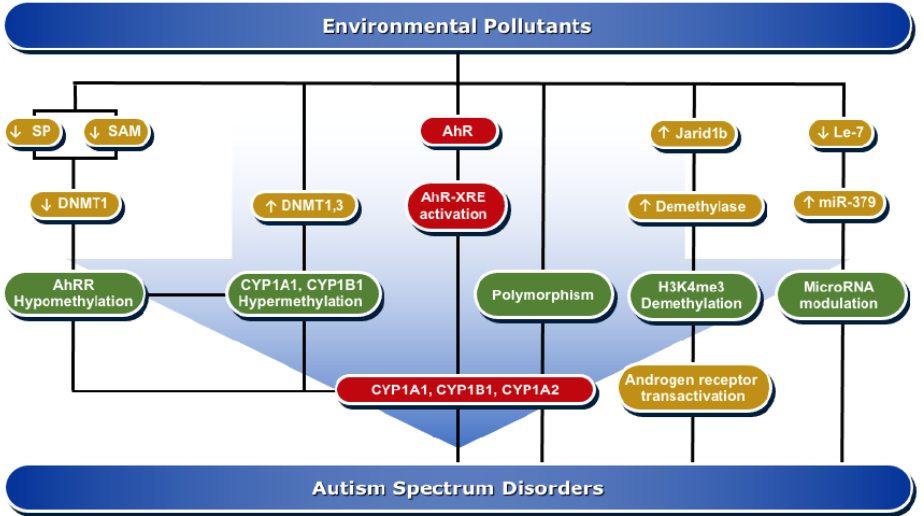
Figure 2. Graphical summary of AhR activation mechanisms in ASD development.